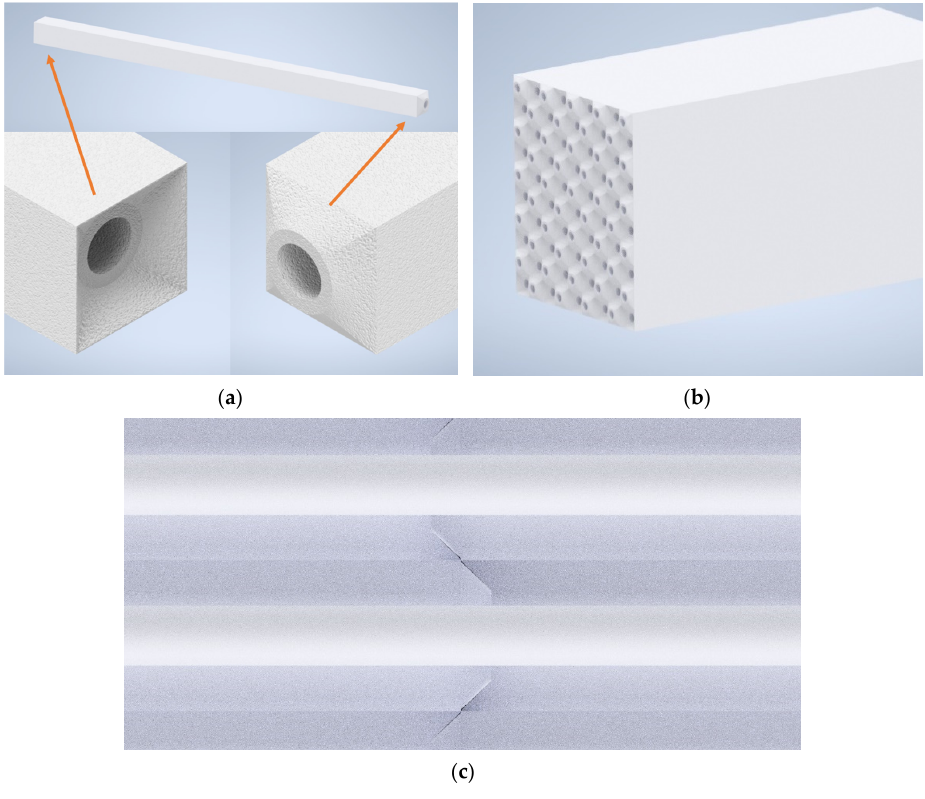
Figure 4. Concrete block concept: ( a ) fitting connections, ( b ) stacked distribution example, ( c ) connection points.